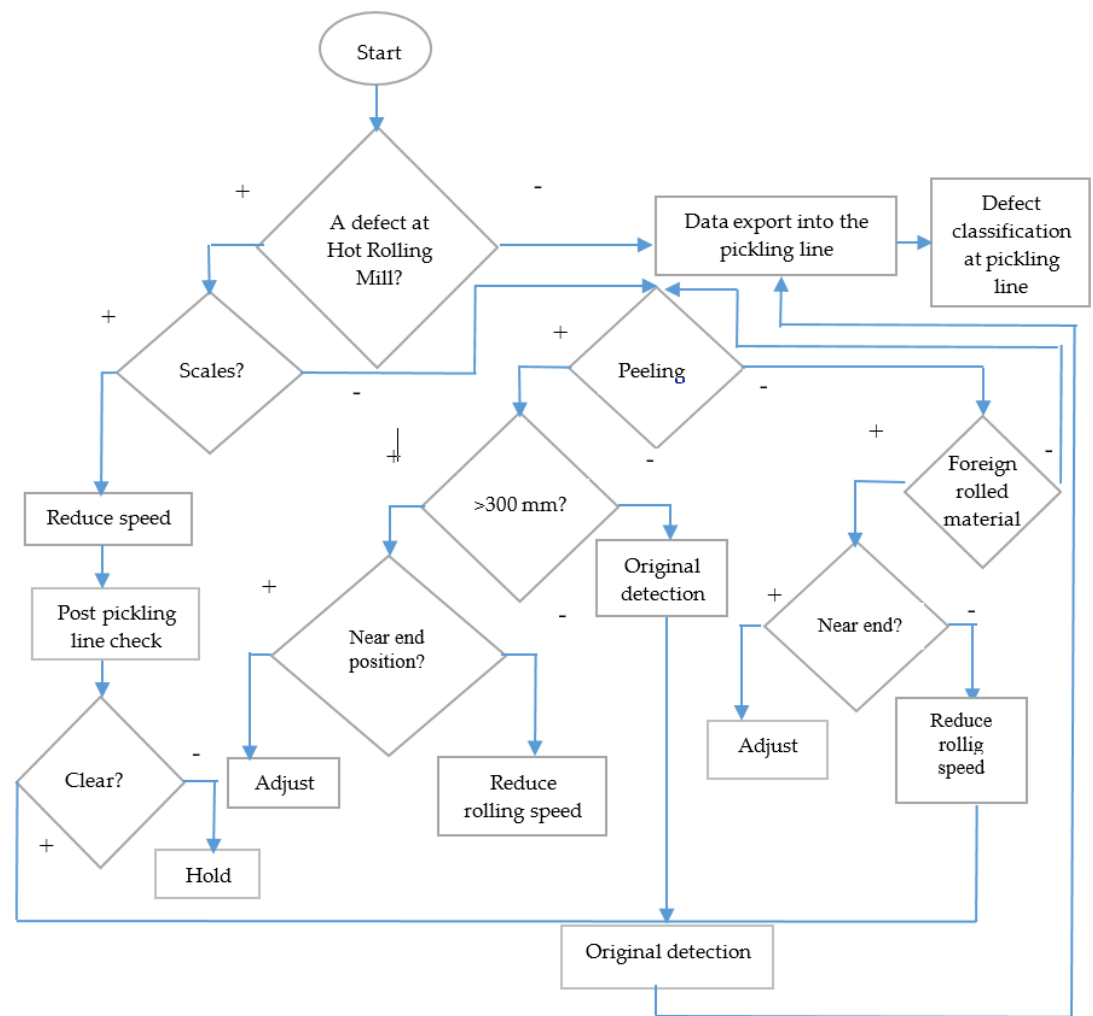
Figure 13. Two-step defect detection flow chart design.